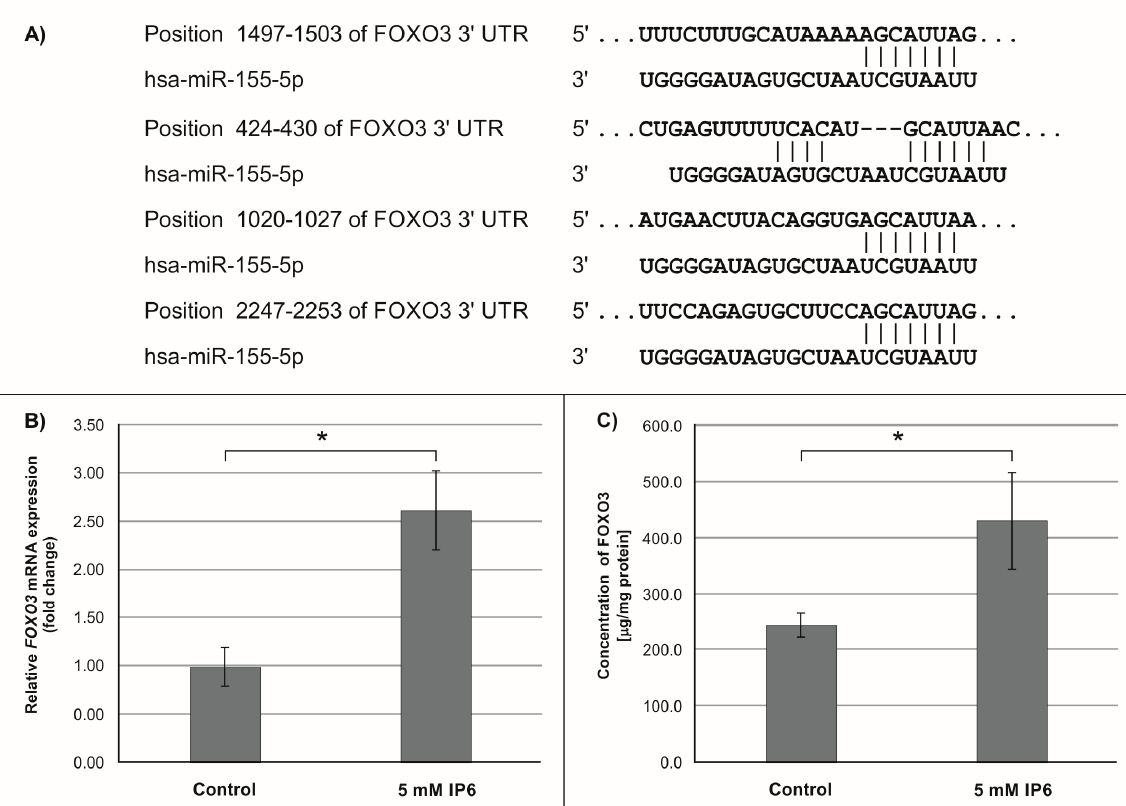
Figure 4. Effect of 5 mM IP6 on FOXO3a gene expression in Caco-2 cells at 24 h. ( A ) Schematic of the putative binding sites of miR-155-5p in 3 ′ -UTR of FOXO3 mRNA, as determined by bioinformatics analysis. ( B ) Changes in FOXO3a mRNA expression in Caco-2 cells, as determined by RT-qPCR. ( C ) Changes in FOXO3a protein concentration in Caco-2 cells, as determined by ELISA test. The results are presented as mean ± SD of three separate experiments; * p < 0.05 versus control.